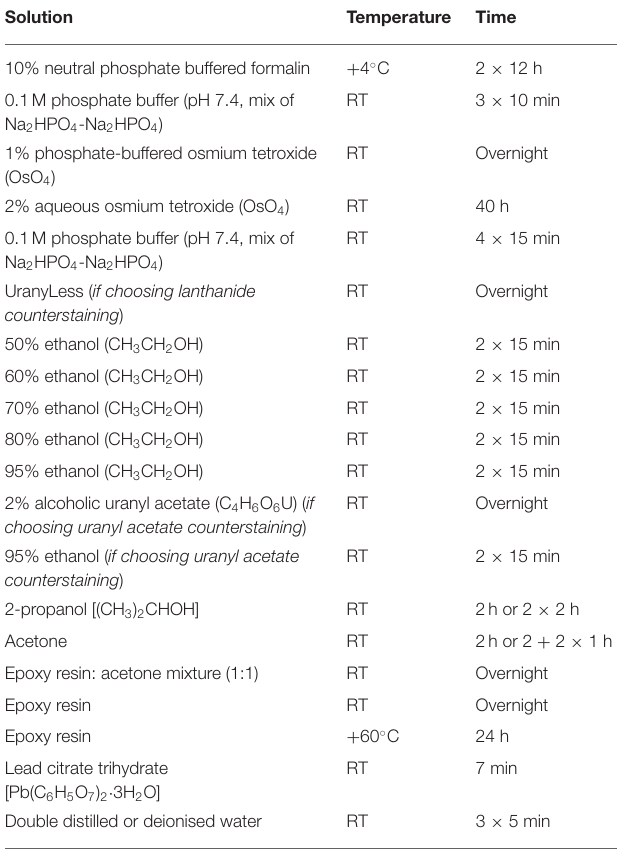
TABLE 1 | Sequence and timing of the sample incubation in chemical reagents.